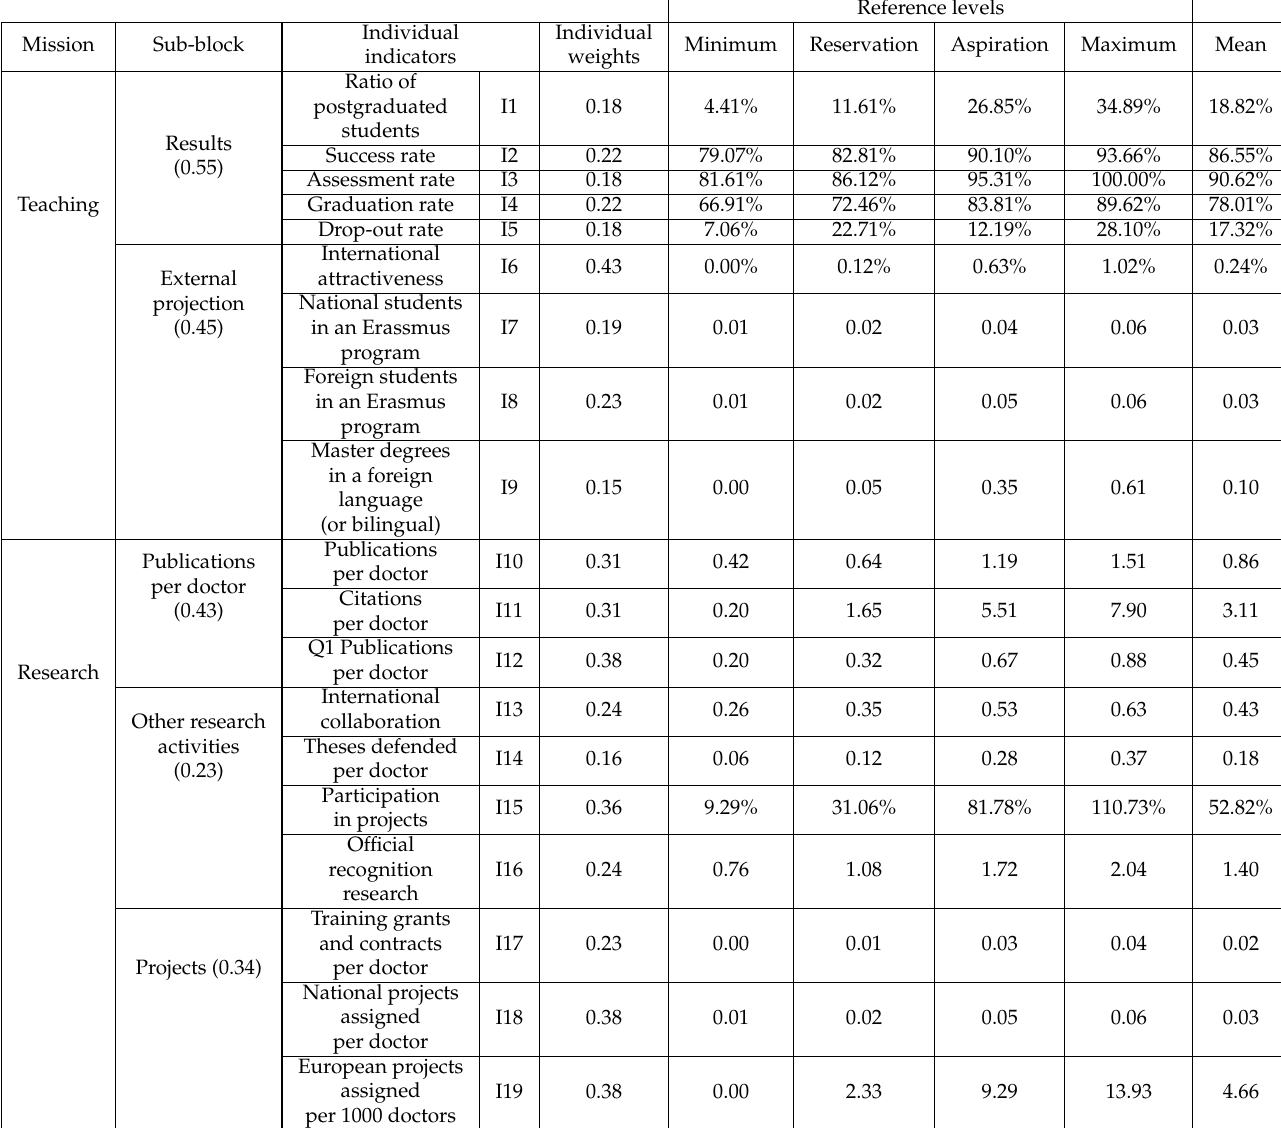
Figure A1. System of indicators and their corresponding reference levels and weights in each mission.